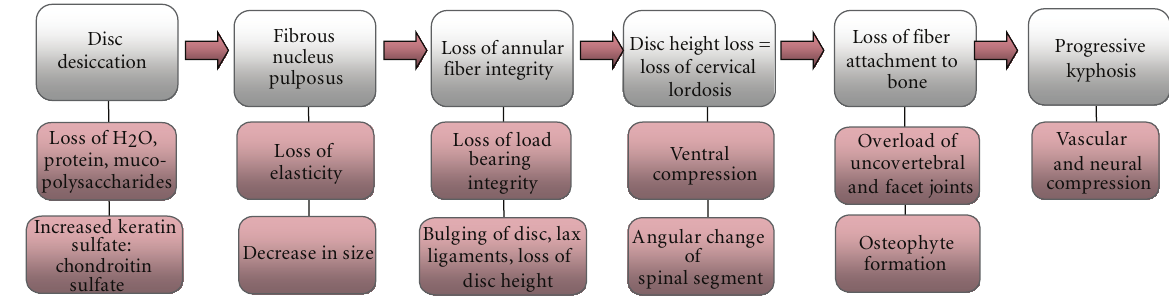
Figure 2: Pathophysiological and biomechanical pathway of cervical